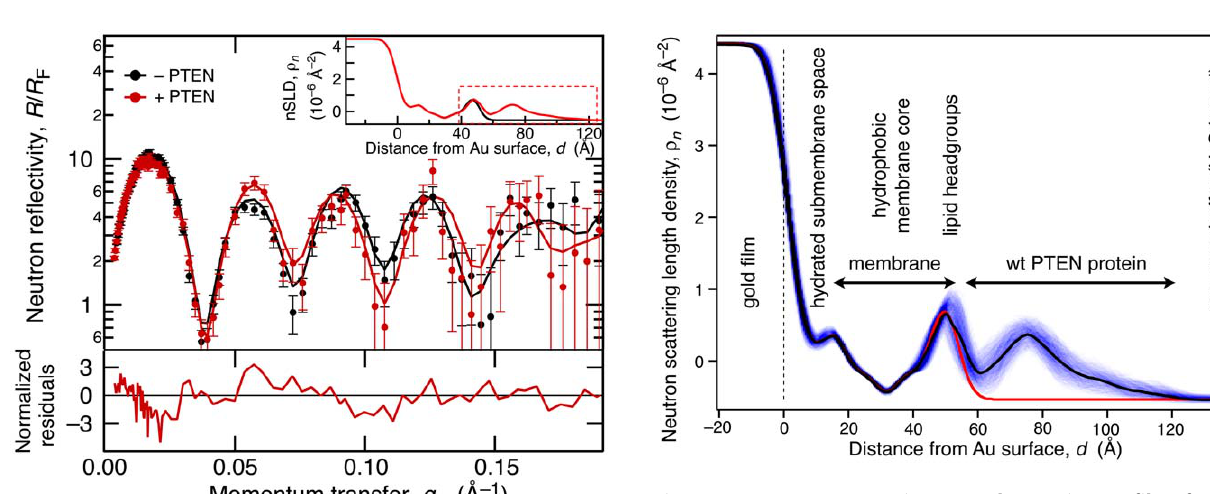
Figure 3. Neutron Scattering Length Density Profile of PTEN Protein Bound to a Lipid Bilayer in an stBLM. nSLD distribution of wt PTEN bound to a thermally disordered lipid membrane composed of DOPC with 30 mol% DOPS ( + chol), as determined in a Continuous Distribution (CD) model. The sample is the same as that shown in Fig. 2. The red and black lines show those profiles for the as-prepared stBLM and the same sample after protein adsorption from a 20 m M PTEN solution, respectively, that derive from the most likely parameter set (Table 3). For the sample with PTEN protein, blue shaded contours visualize the bandwidth (1 s ) of nSLD profiles that are also consistent with the experimental results, as determined by Monte-Carlo resam- pling of the data. The intensity of the shading corresponds to the probability of the model to be a true representation of the underlying